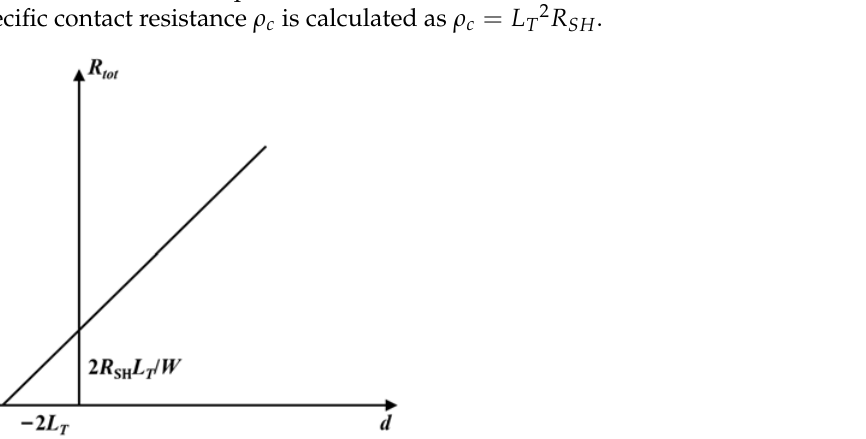
Figure 2. The curve of R tot versus d . The slope of the curve is R SH / W , and the intercept is 2 R SH L T / W .